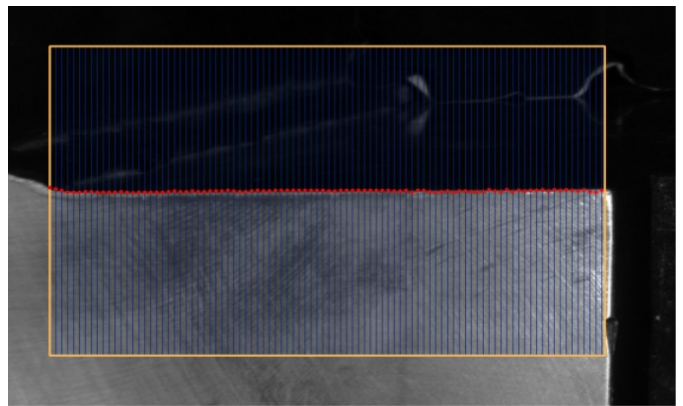
Figure 9. The effect of edge point extraction.